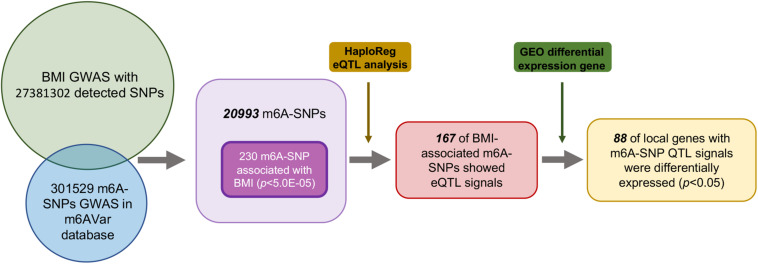
Flow chart of study design and the main results.